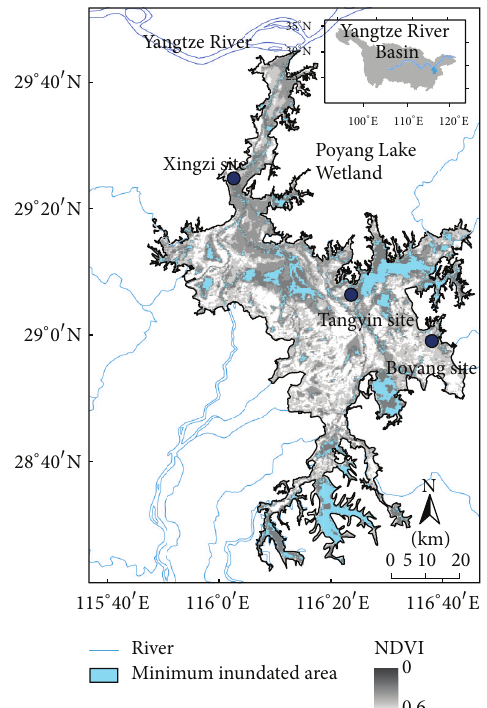
Figure 1: Geographic location of Poyang Lake wetland with mini- mum water surface areas in